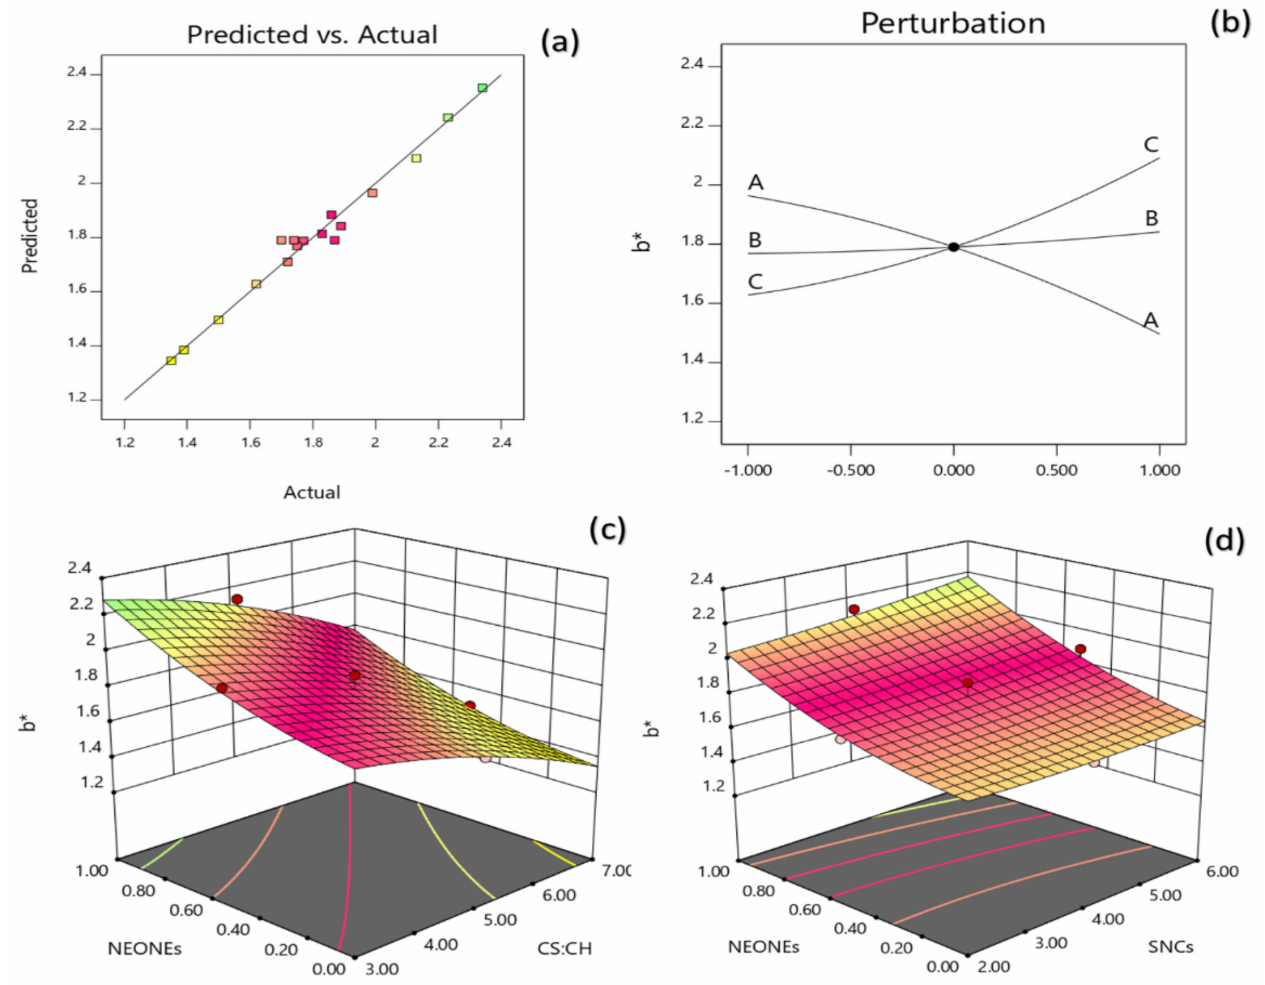
Figure 7. Counter and perturbation graphs ( a , b ), the interaction between CS:CH and SNCs concentration and also interaction between SNCs and NEONEs concentration on b* parameter of the produced film ( c , d